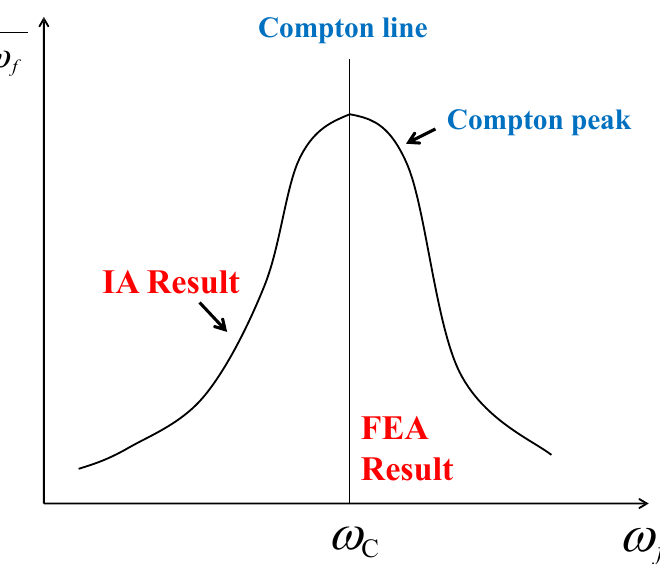
Figure 2. Schematic plot of the FEA and IA results of DDCS at scattering angle θ . The horizontal axis labels the finial photon energy ω f , and the vertical axis labels the DDCS of Compton scattering